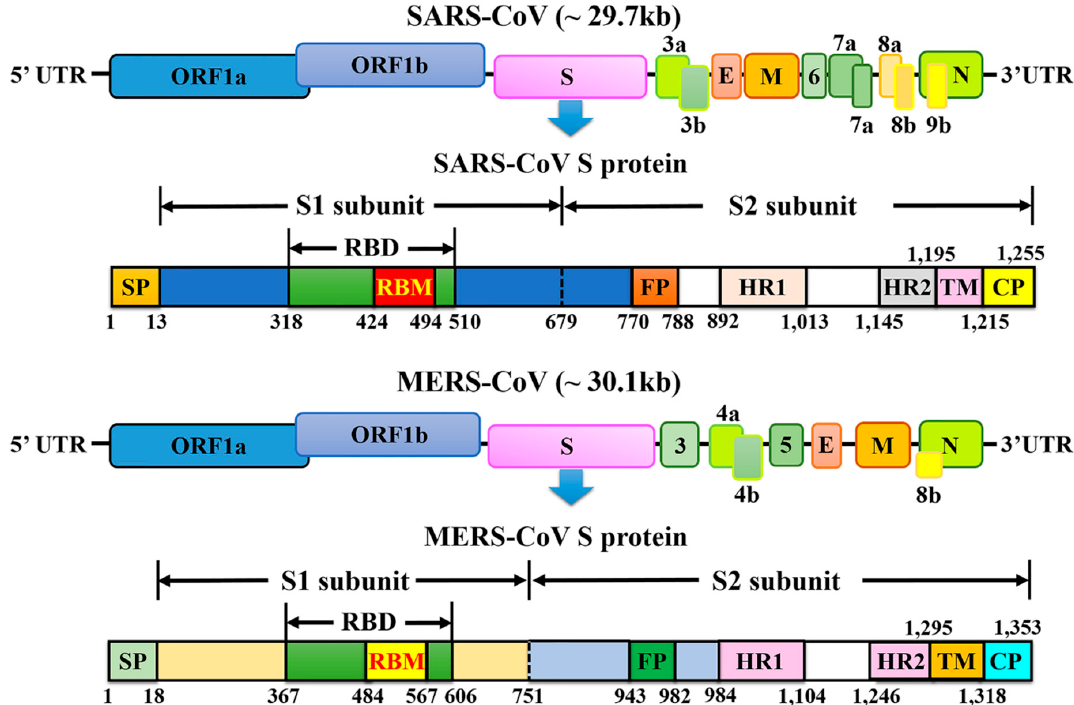
Figure 1. Schematic representation of the genome organization and functional domains of S protein for SARS-CoV and MERS-CoV. The single-stranded RNA genomes of SARS-CoV and MERS-CoV encode two large genes, the ORF1a and ORF1b genes, which encode 16 non-structural proteins (nsp1–nsp16) that are highly conserved throughout coronaviruses. The structural genes encode the structural proteins, spike (S), envelope (E), membrane (M), and nucleocapsid (N), which are common features to all coronaviruses. The accessory genes (shades of green) are unique to different coronaviruses in terms of number, genomic organization, sequence, and function. The structure of each S protein is shown beneath the genome organization. The S protein mainly contains the S1 and S2 subunits. The residue numbers in each region represent their positions in the S protein of SARS and MERS, respectively. The S1/S2 cleavage sites are highlighted by dotted lines. SARS-CoV, severe acute respiratory syndrome coronavirus; MERS-CoV, Middle East respiratory syndrome coronavirus; CP, cytoplasm domain; FP, fusion peptide; HR, heptad repeat; RBD, receptor-binding domain; RBM, receptor-binding motif; SP, signal peptide; TM, transmembrane domain.